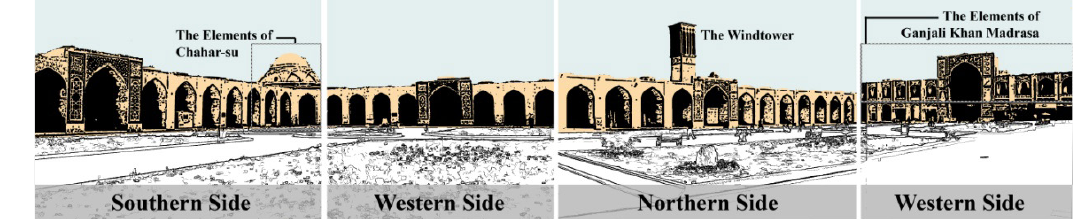
Figure 3. Various combinations of qualities are manifested in Ganjali Khan Complex